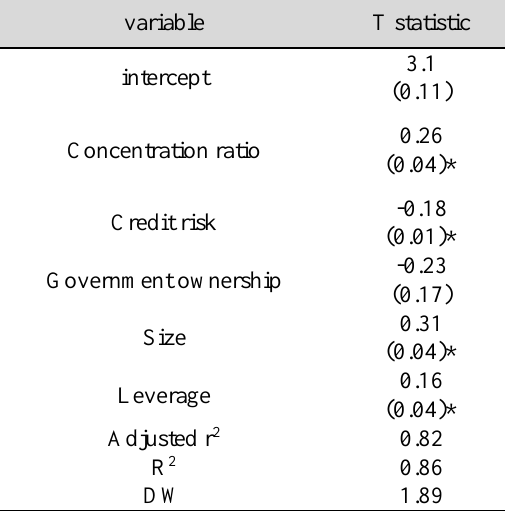
Table 4: Estimation results (dependent variable: return on